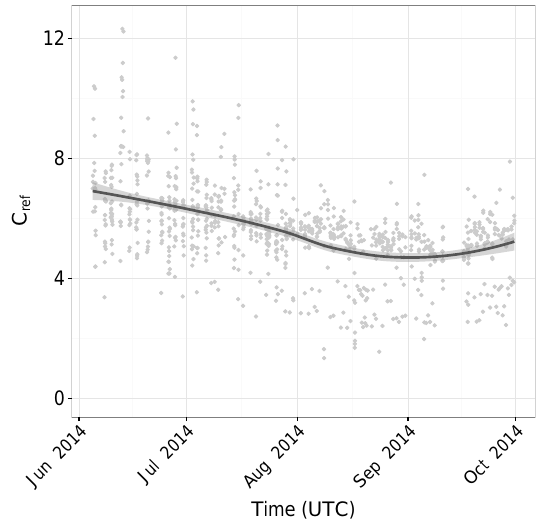
Figure 2. Multiple scattering correction calculated by using MAAP absorption coefficients as reference ( λ = 637nm). Light-gray points represent all calculated C ref values. The black line and shaded area represent a conditional non-parametric mean estimation and its con- fidence limits,